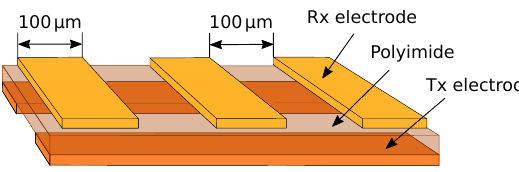
Figure 1: Schematic cross section of the envelope mesh with overlapping Rx and Tx electrodes.